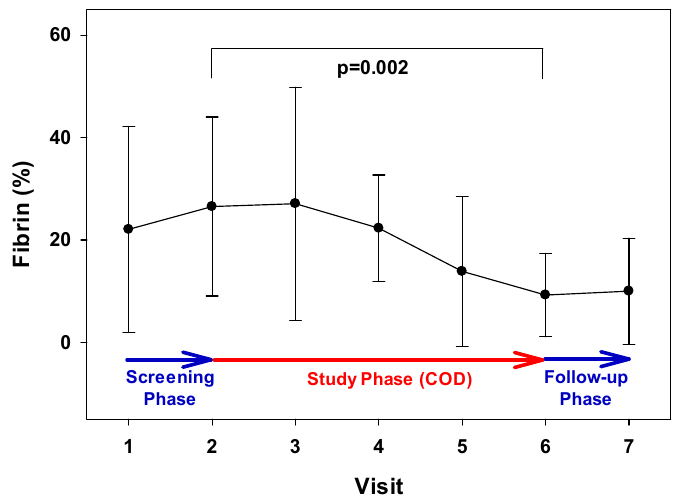
Figure 8. Reduction in fibrin tissue during the Treatment Phase. There was a statistically significant reduction in the percentage of fibrin during Visits 2 to 6 (47.8%; p = 0.002, one-way repeated measures ANOVA).